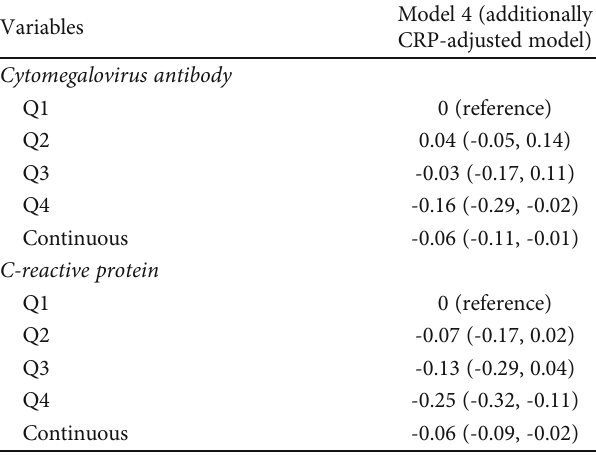
Table 4: Joint association of cytomegalovirus antibody and CRP with telomere length in